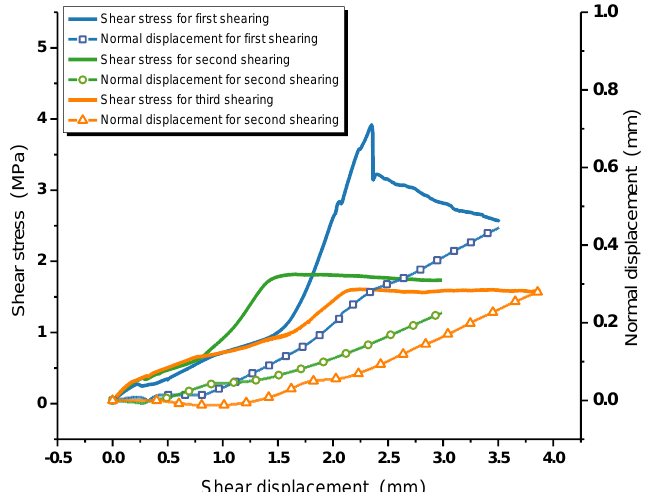
Figure 9. The relationship between normal displacement and shear displacement.